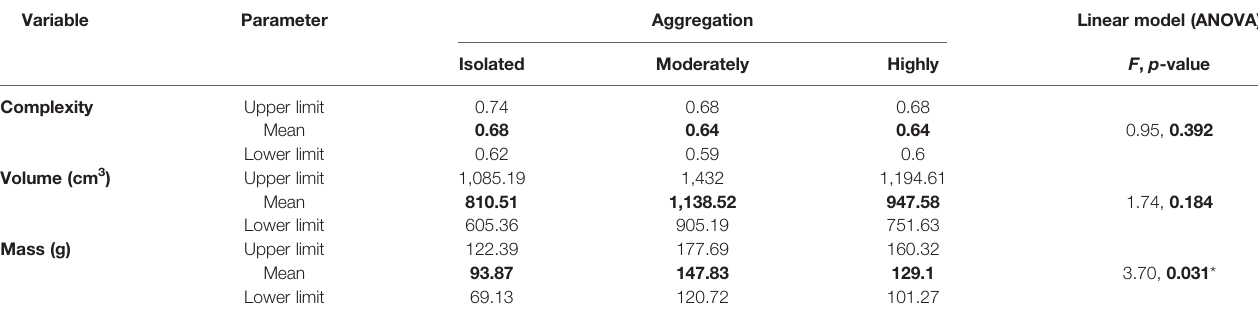
TABLE 2 | Mean value and their upper and lower limits of 95% of con fi dence for the rhodolith characteristics by the three levels of aggregation of rhodoliths at Isla del Coco.